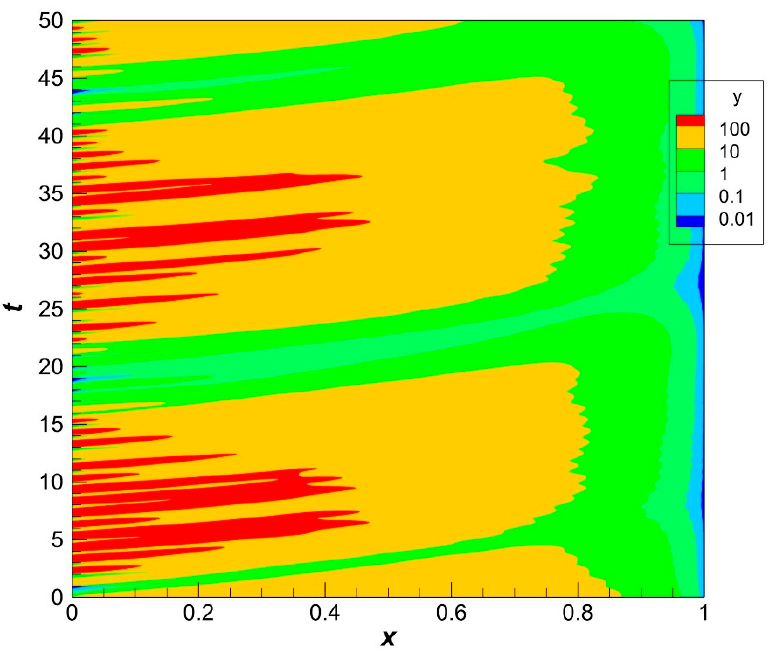
Figure 7. The fluctuations of population density y ( t , x )